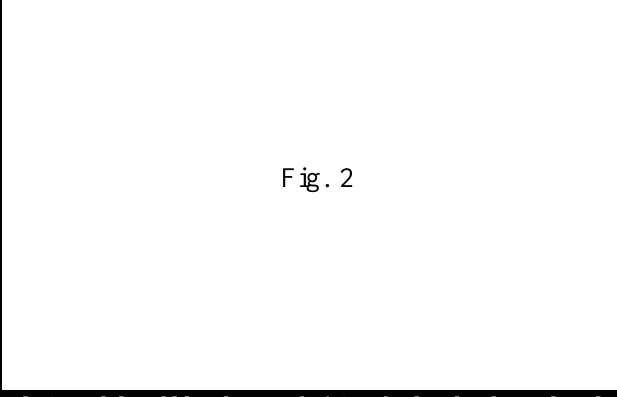
Fig.2, Peripheral blood smear (2 nd Case), showing hypochronic, microcytic red blood cells with occasional sickle